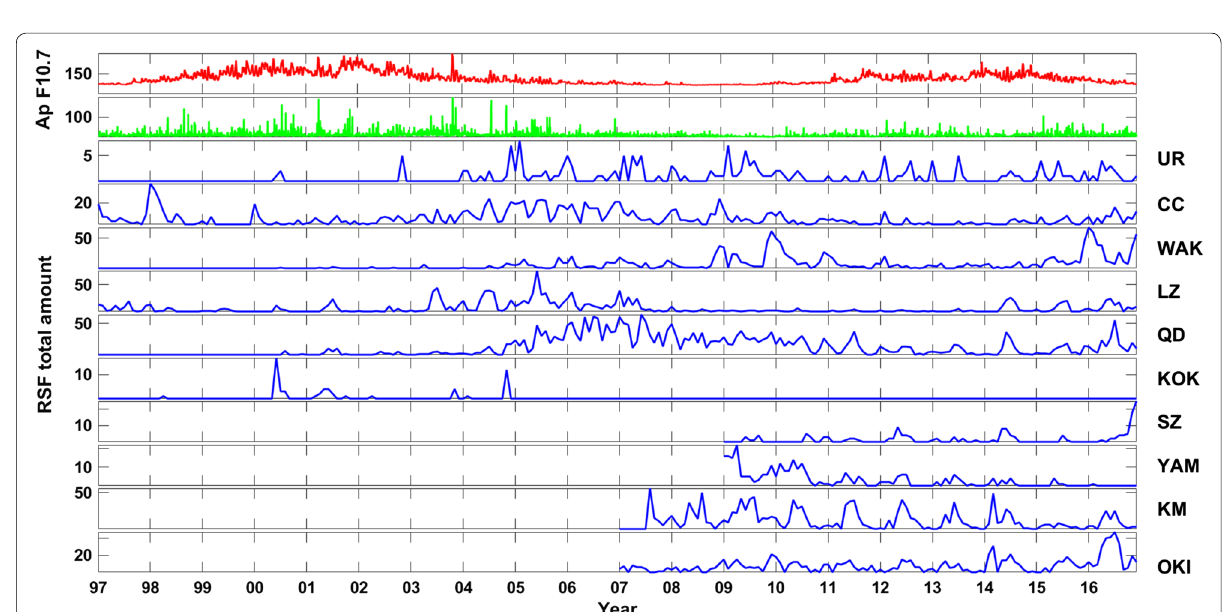
Fig. 7 Variations in daily F10.7, Ap index and RSF total amount at the 10 stations; the x -axis is the year and the y -axis is the RSF total